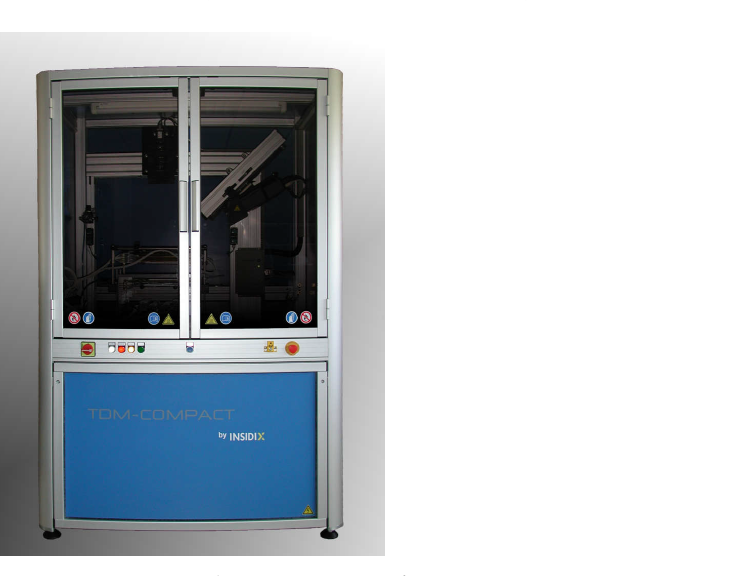
Figure 2. Experimental equipment TDM for warpage